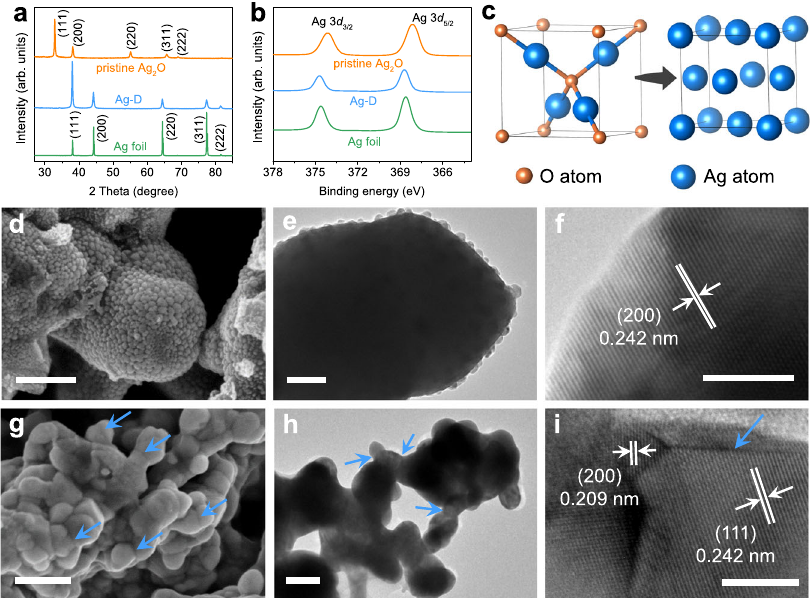
Fig. 1 Materials characterization of Ag 2 O, Ag-D and Ag foil samples. a XRD patterns. b Ag 3 d XPS spectra. c Crystal structure schematics of Ag 2 O (left) and Ag (right). d, g SEM images of Ag 2 O and Ag-D samples. e, h Typical TEM images of Ag 2 O and Ag-D samples. f, i HRTEM images of Ag 2 O and Ag-D samples. Scale bar in d , g is 250 nm, in e is 50 nm, in h is 100 nm and in f , i is 5